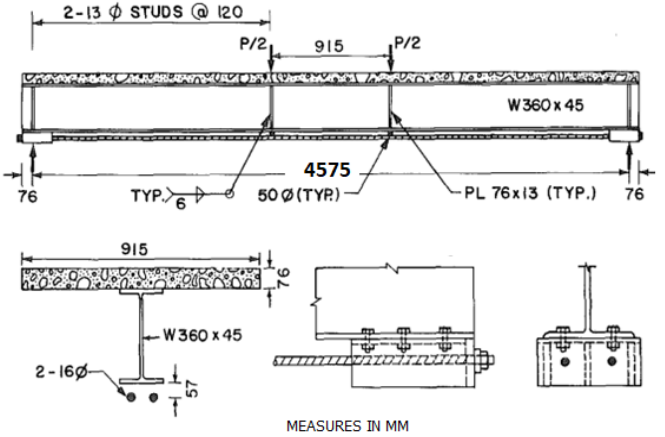
Figure 2. Test setup of the 4.575 m span prestressed steel-concrete composite beam. Source: Ayyub et al.